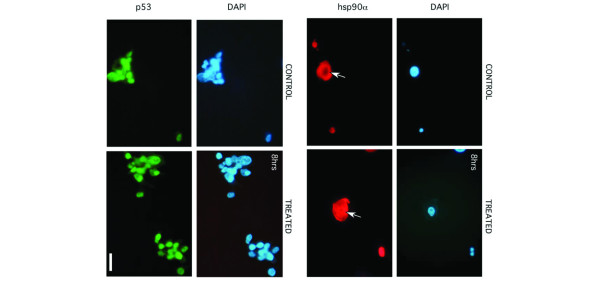
The nuclear localization of the α isoform of heat shock protein 90 (Hsp90α) is enhanced by treatment of cells with PRIMA-1. MDA-231 cells treated with PRIMA-1 were subjected to nuclear isolation. A fraction of the isolated nuclear pellet was fixed in 4% paraformaldehyde, permeabilized in 0.1% Triton X-100 and incubated overnight with anti-p53 and anti-Hsp90α monoclonal antibodies. Nuclear fractions were then immunostained with a secondary antibody conjugated with Oregon green to detect p53 (green) and a secondary antibody conjugated with Texas red to detect Hsp90α (red) before detection by fluorescence microscopy. Nuclei were stained with 4',6-diamidino-2-phenylindole (blue). Normal mouse immunoglobulin G was used as a negative control (data not shown). Arrows mark nuclear staining of Hsp90α. Scale bar, 5 μm.